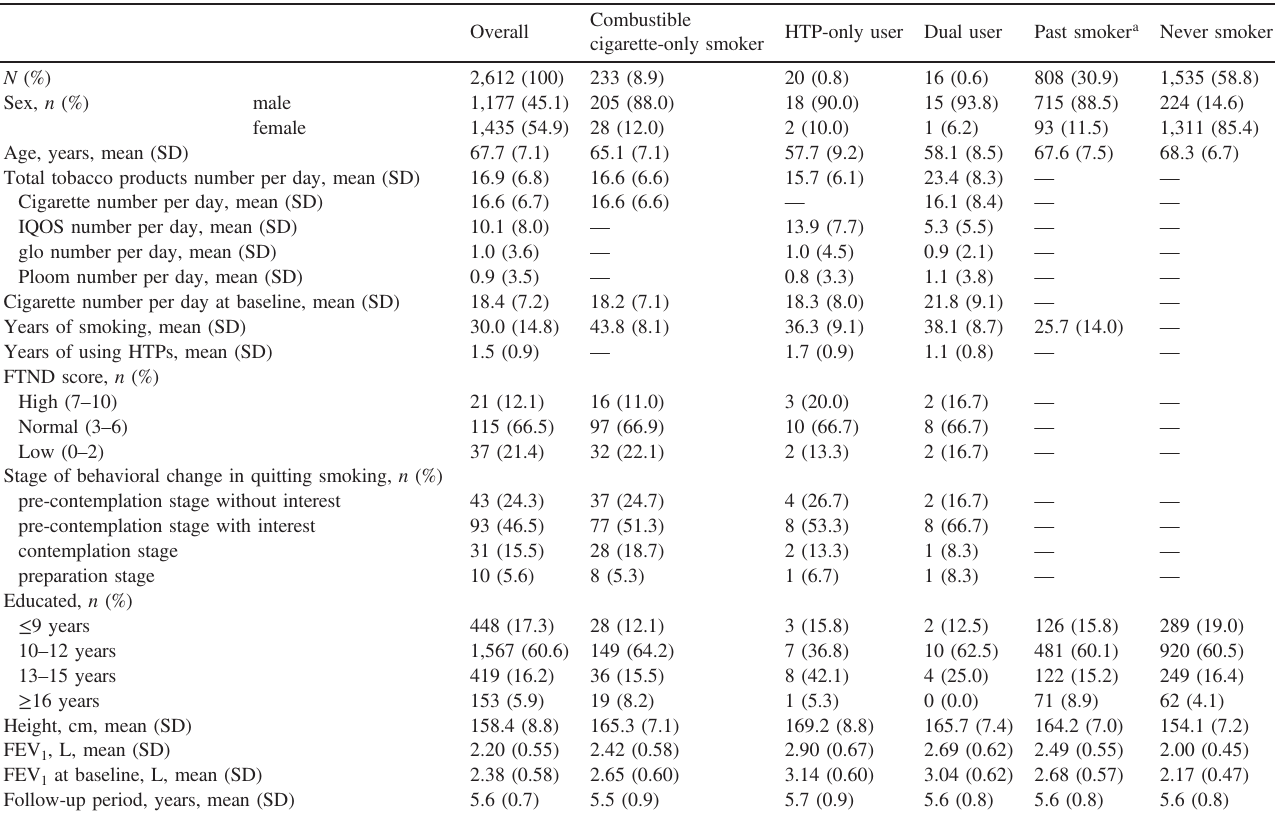
Table 1. Characteristics of the resident population in the follow-up survey